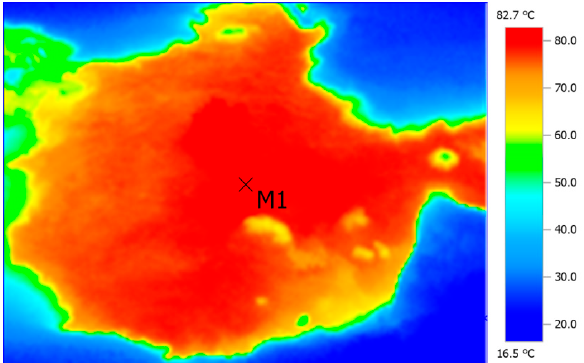
Figure A4. Shaman geyser pool pre-eruption infrared (IR) (testo-865) view. Photo by A. Kiryukhin, 24 August 2019.